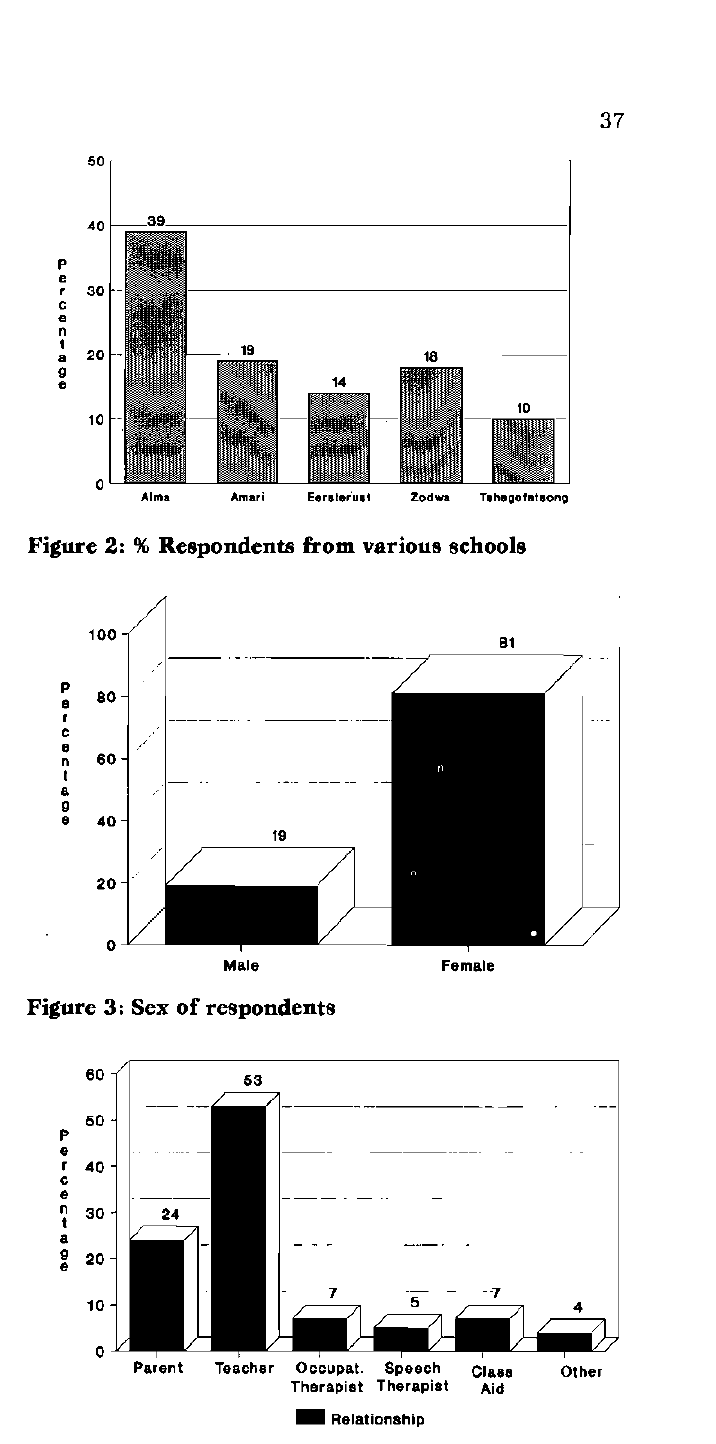
Figure 4: Relationship of respondent to disabled